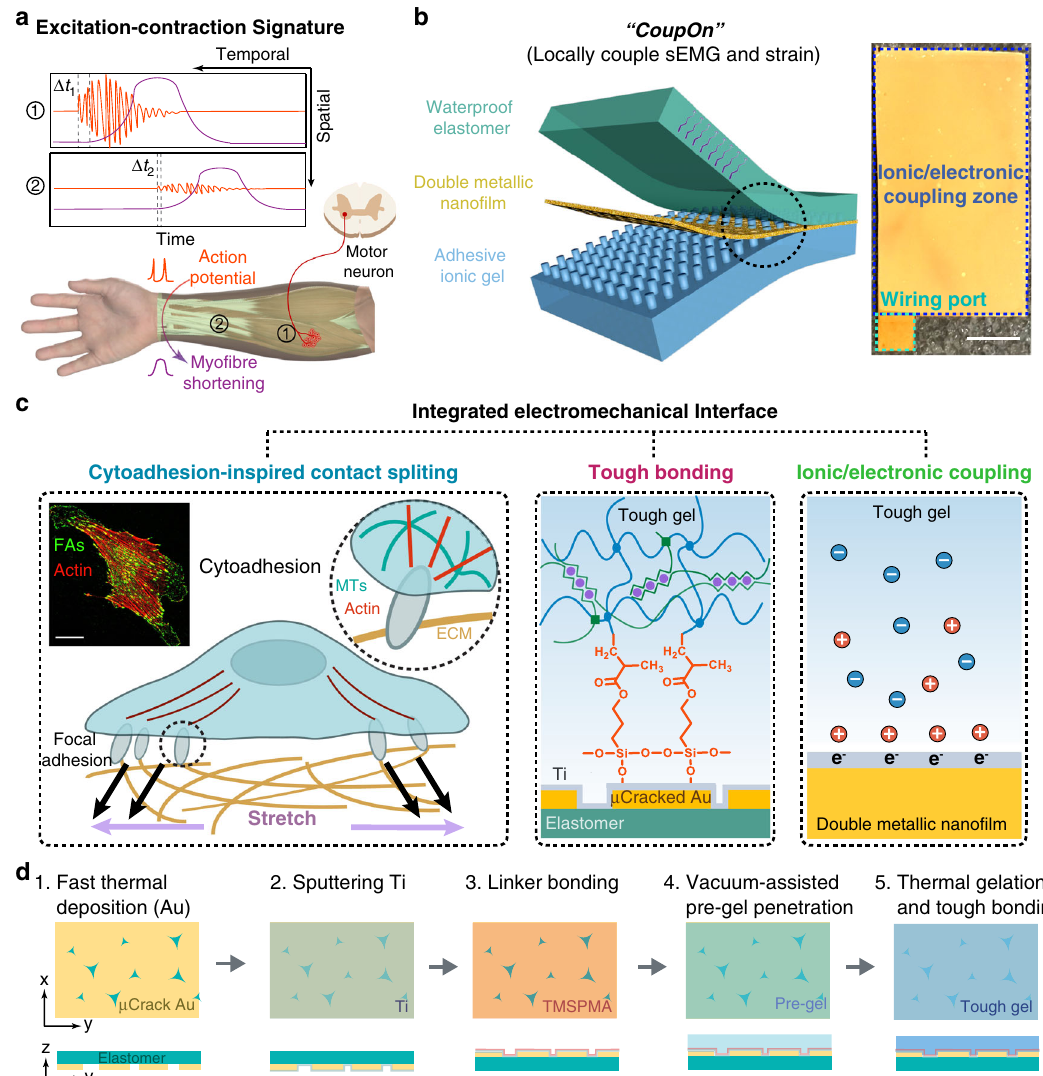
Fig. 1 Cytoadhesion-inspired quadra-layered hybrids. a Schematic shows the temporal and spatial differences in the patterns of myoelectric excitation and mechanical contraction in the excitation – contraction coupling process during voluntary muscle contraction. b Schematic of the integrated electromechanical interface (i.e., CoupOn ). Right photograph shows one fabricated CoupOn hybrid with the ionotronically conductive zone and the wiring port annotated. The adhesive ionic hydrogel retrieves sEMG signals and the stretchable double metallic nano fi lm functions as the resistive strain sensor while transmitting the electrical signals for readouts. The waterproof elastomer mitigates water loss from the ionic hydrogel. Scale bar, 5 mm. c Schematic of strong interlayer adhesion at the integrated electromechancial interface that combines the cytoadhesion-inspired contact splitting and tough interfacial bonding, illustrating dash ciricle in c . Inset, confocal fl uorescent images showing an adherent fi broblast labeled with actin micro fi laments (red) and focal adhesions (green). Scale bar, 30 µ m. d Schematic of the fabrication process of the hybrid CoupOn in fi ve